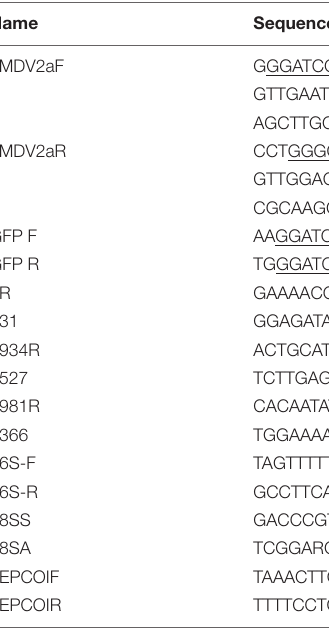
TABLE 1 | Primers used in this